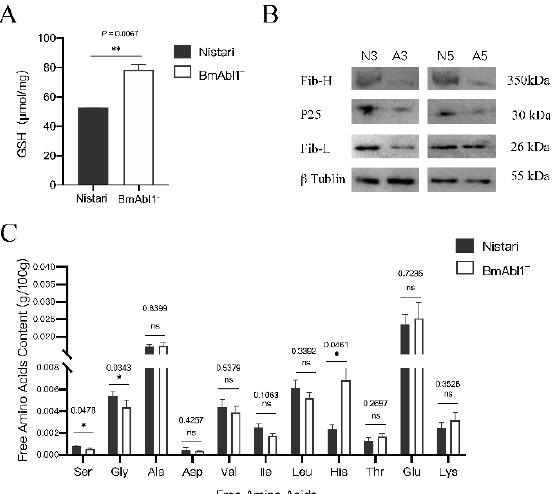
Figure 6. Abnormality of glutathione metabolism led to the reduction of fibroin protein. ( A ) Inhibition of glutathione metabolism pathway led to the accumulation of glutathione; ( B ) inhibition of glutathione metabolism pathway led to reduction of Gly and Ser; ( C ) the content of fibroin proteins decreased in BmAbl1 - . N3: Nistari l5d3; A3: BmAbl - l5d3; N5: Nistari l5d5; A5: BmAbl - l5d5. Standard deviation was calculated by all biological replicates. * p < 0.01, ** p < 0.005, t -test.